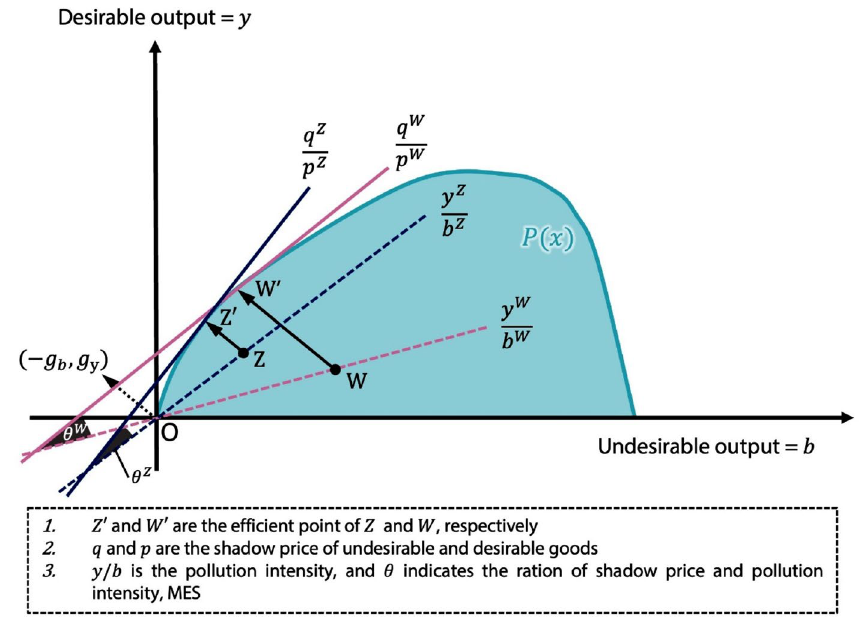
Figure 2. Output set (directional output distance) and associated shadow